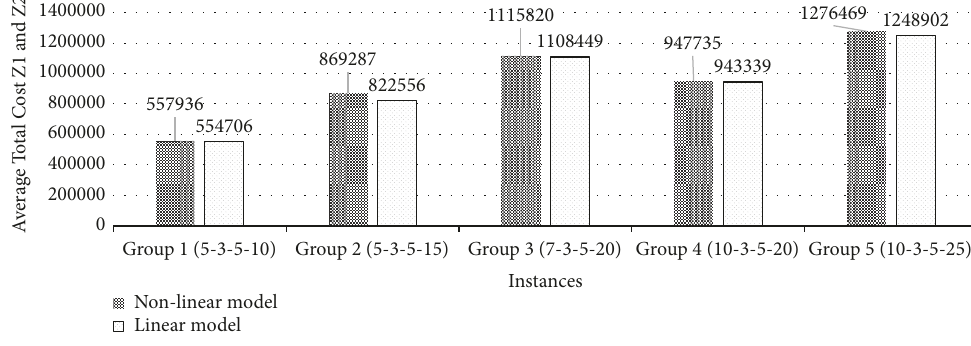
Figure 4: Average total cost, comparing the nonlinear versus the linear models.